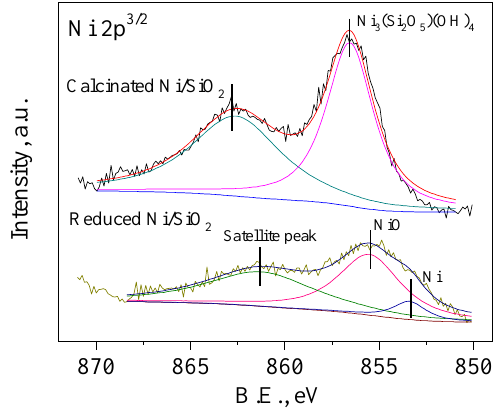
Figure A1. XPS spectra of the calcinated and reduced catalysts.